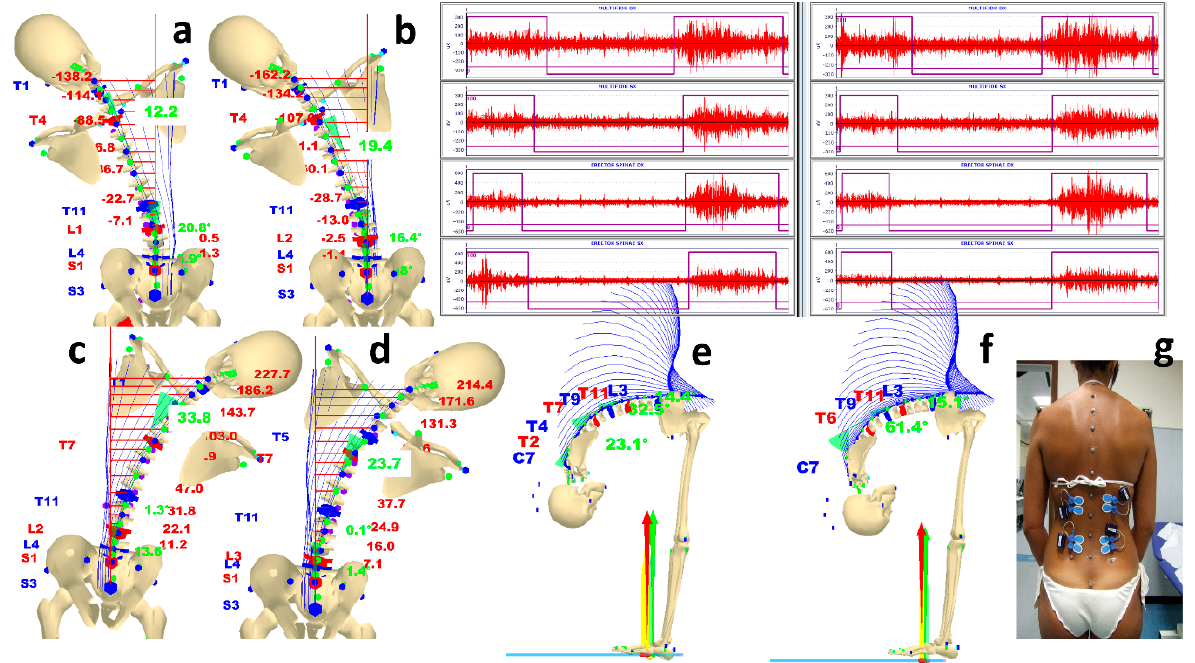
Figure 7. Spine mobility evaluation in lateral- and forward-bending. Panels ( a ) vs. ( b ) and ( c ) vs. ( d ) show the comparison of performances between without ( a , c ) and with ( b , d ) foot orthoses during lateral bending. Panels ( e ) vs. ( f ) show the comparison of performances between without and with foot orthoses during the forward-bending associated with the corresponding SEMG activity. Panel ( g ) shows an example of bilateral multifidus and erector spinae electrodes positioning following SENIAM recommendations.